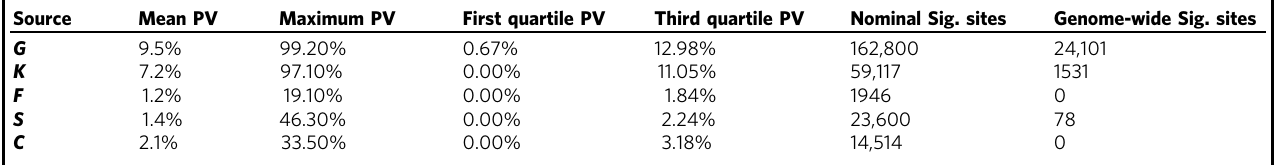
Table 2 DNA methylation variation decomposed into genetic and environmental components